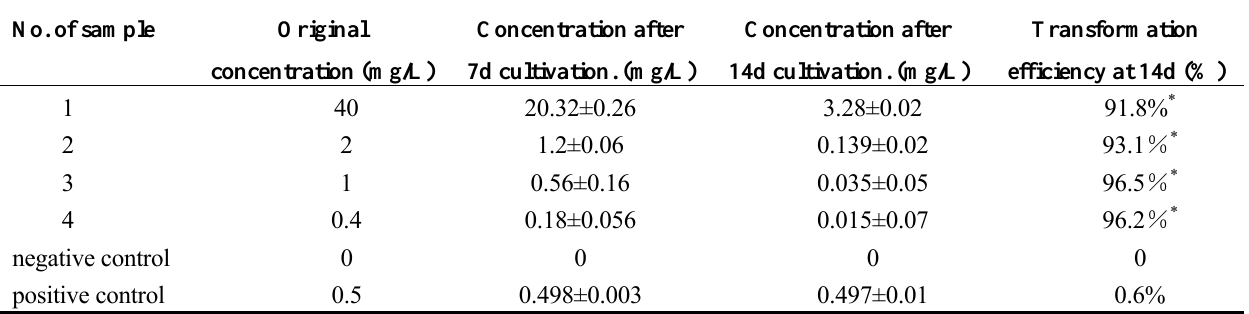
Table 1. The concentration of DON in culture after cultivation for 7 d and 14 d.